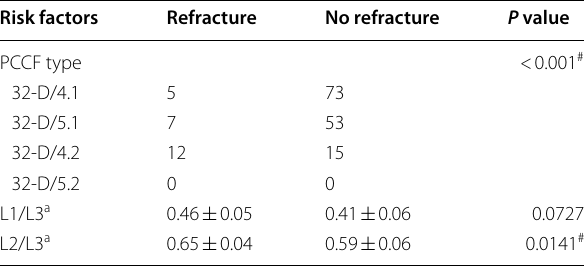
PCCF, AO Pediatric Comprehensive Classification of Long Bone Fractures # Significant difference at P < 0.05